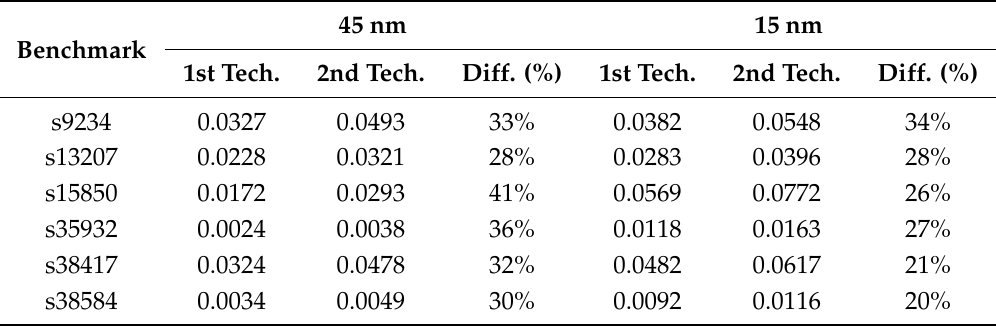
Table 9. SER considering an approximate pulse propagation function and a SPICE-oriented technique for the 45 nm and 15 nm